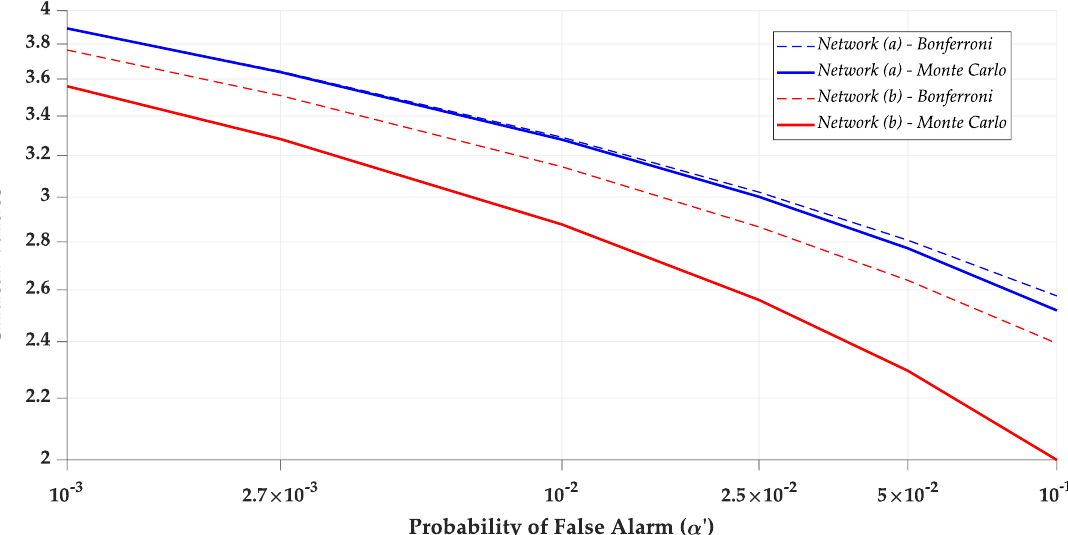
Figure 5. Critical values of max- w for both levelling networks ( a ) in blue and ( b ) in red. Solid curves were obtained from the Monte Carlo procedure in Section 4 with m = 200,000 Monte Carlo experiments. Dashed curves were obtained from Bonferroni in (22).